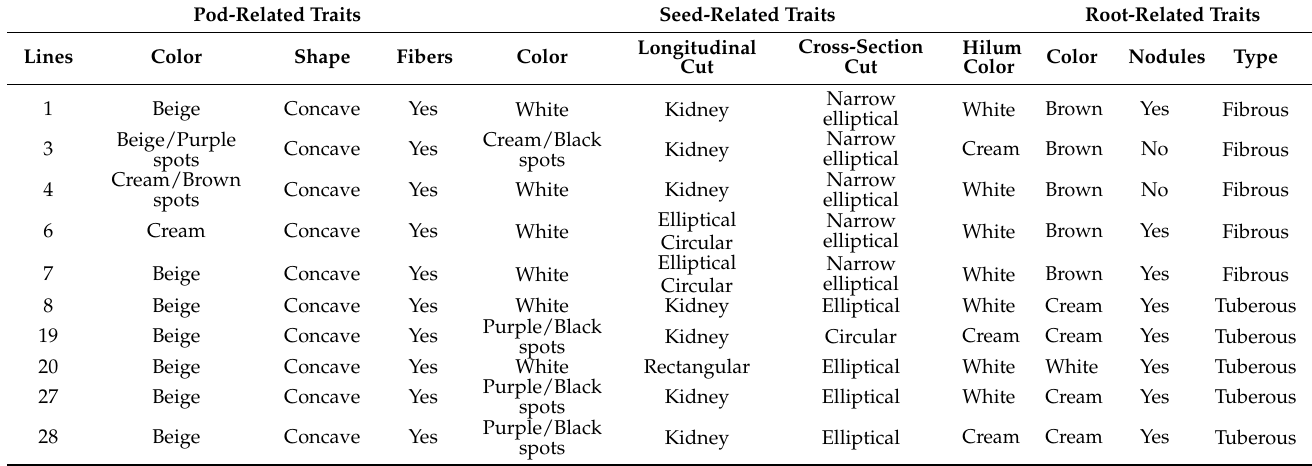
Table 2. Qualitative traits related to the pod, seed and root of the P. coccineus lines. The traits that are presented in the table are those that were found more frequently within each line (from six plants each). The traits related to the root were evaluated at the time of